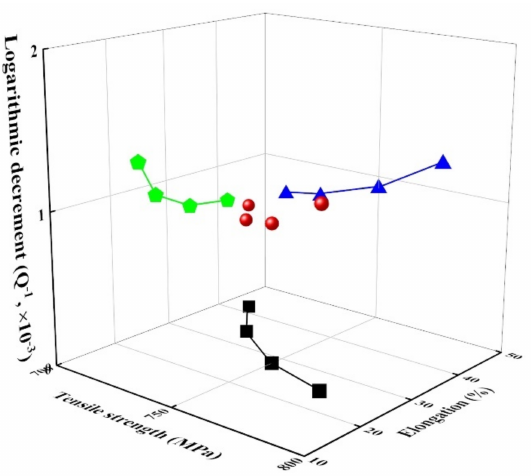
Figure 7. Relationship between the mechanical properties and logarithmic decrement in fatigue- between logarithmic decrement and elongation, blue triangles: The relationship between logarith- mic decrement and tensile strength, and black squares: The relationship between tensile strength and